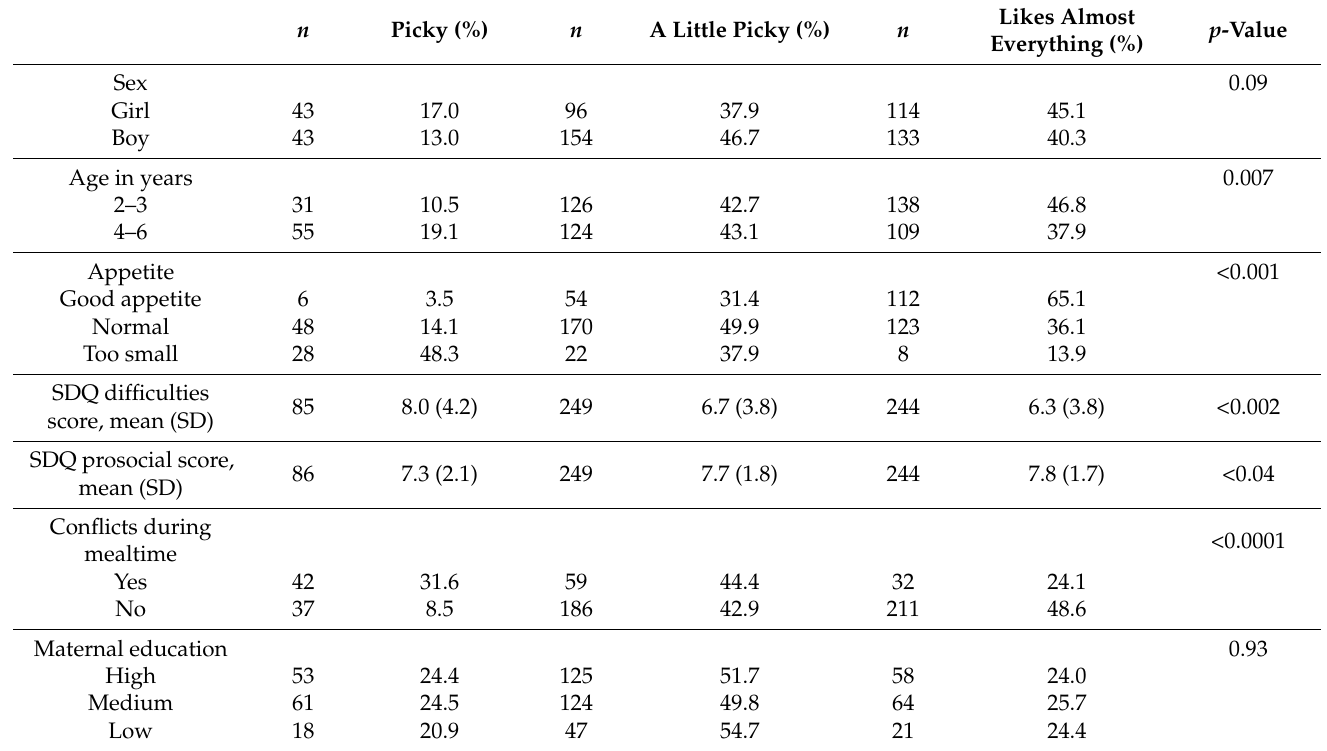
Table 1. Child characteristics according to picky-eating